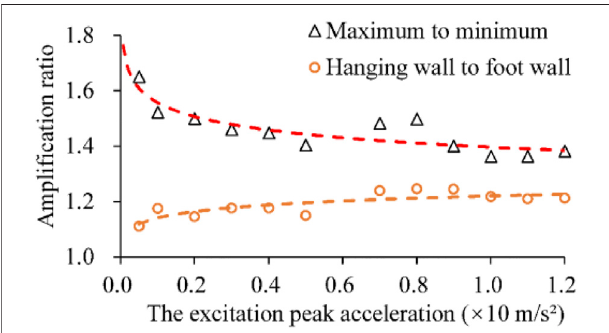
FIGURE 10 | In fl uence of faults on the responsive peak acceleration distribution.